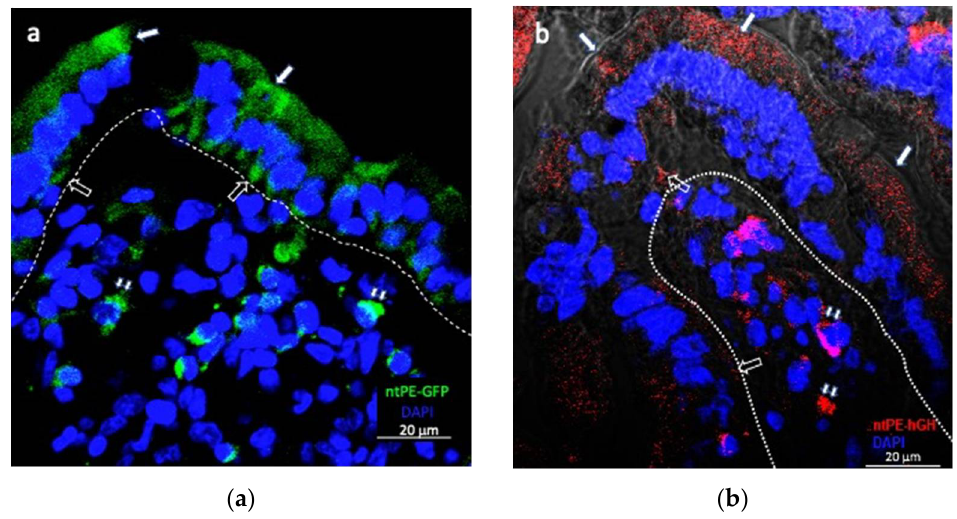
Figure 6. Representative confocal fluorescence image of ( a ) ntPE-GFP or ( b ) ntPE-hGH fate following intra-luminal injection (ILI) into rat jejunum. A non-toxic version of Pseudomonas aeruginosa exotoxin A (ntPE) genetically fused to green fluorescent protein (GFP) or human growth hormone (hGH) was examined for its tissue distribution at 15 min post-ILI. ntPE-GFP can be observed in vesicular structures within the apical region (solid arrow) and basal region of enterocytes of the epithelium. ntPE-GFP that has completed the transcytosis process can be seen in non-polarized cells within the lamina propria (small double solid arrows). Lamina propria-epithelium demarcation = dashed line. Nuclei were stained blue with DAPI. Scale bar = 10 µm.